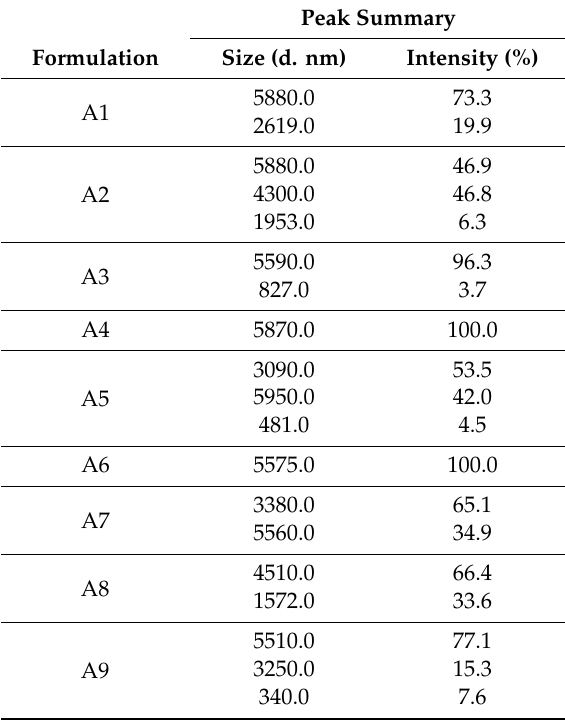
Table 4. Particle size results of diluted aqueous nepafenac eye drops. Data reported are means of three